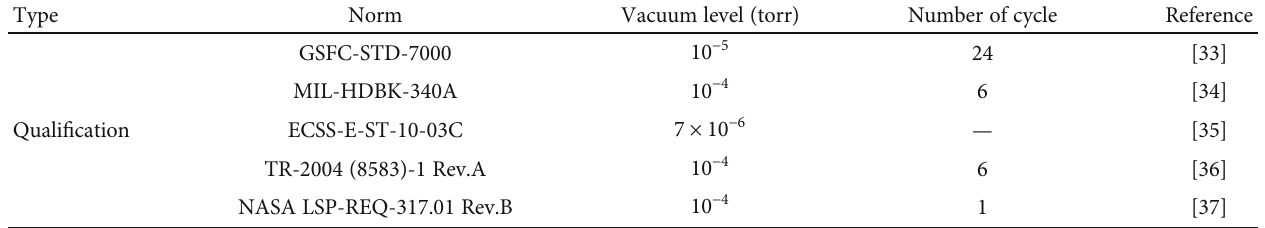
Table 3: Some references of quali fi cation test regulations for CubeSat satellite systems, their common vacuum levels, and number of cycles.